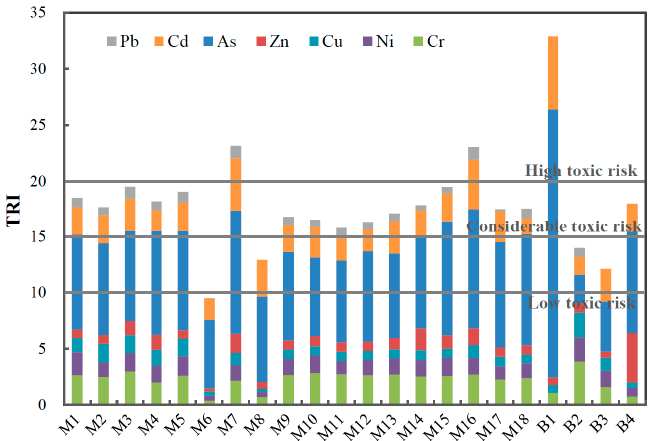
Figure 6. The toxic risk index (TRI) of heavy metal(loid)s of SPM in the Zhujiang River.